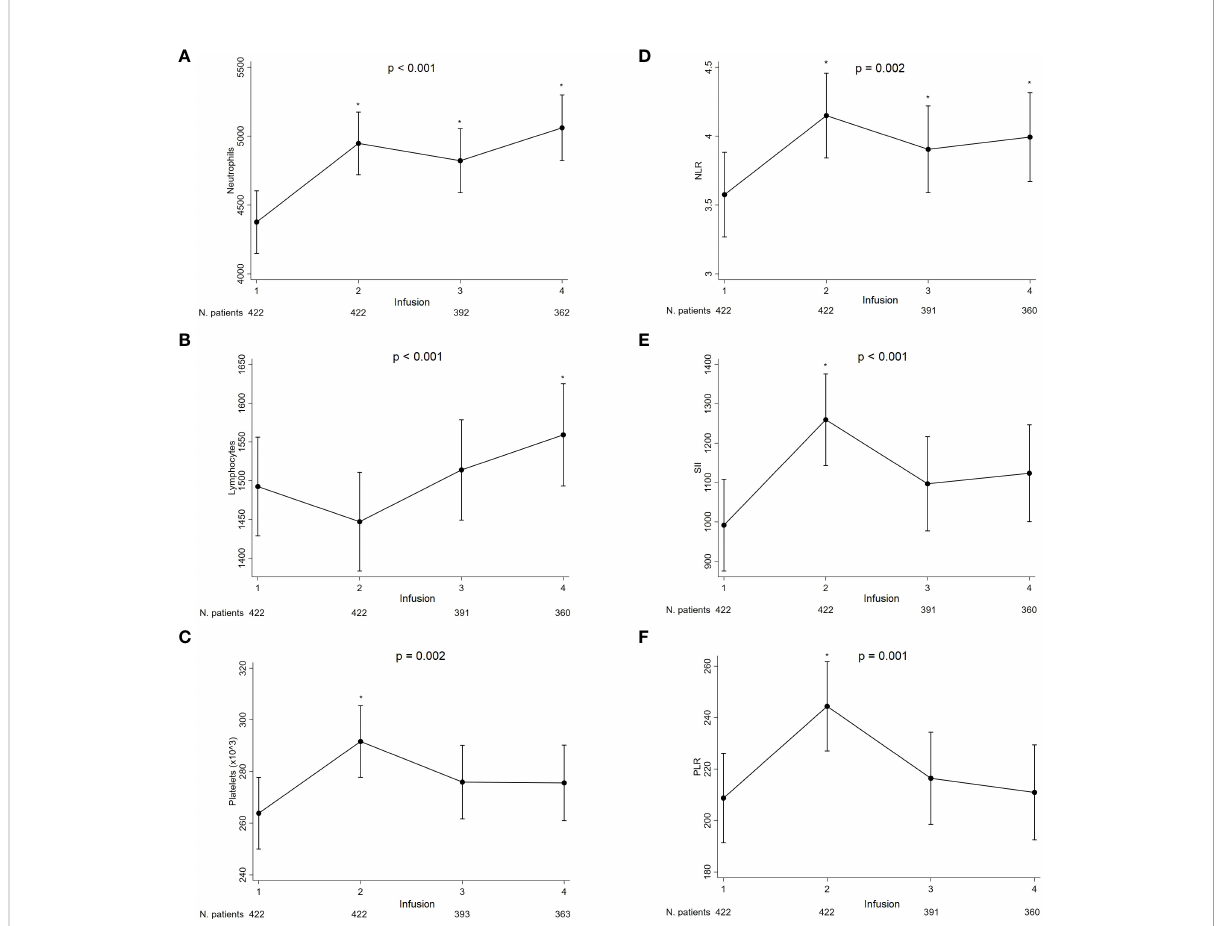
FIGURE 1 The ACC and IR D values through the fi rst four nivolumab administrations.Neutrophils (A) , lymphocytes (B) , platelets (C) , NLR (D) , SII (E) and PLR (F) were assessed.*Signi fi cant difference compared with baseline and adjusted for multiple comparisons using the false discovery rate